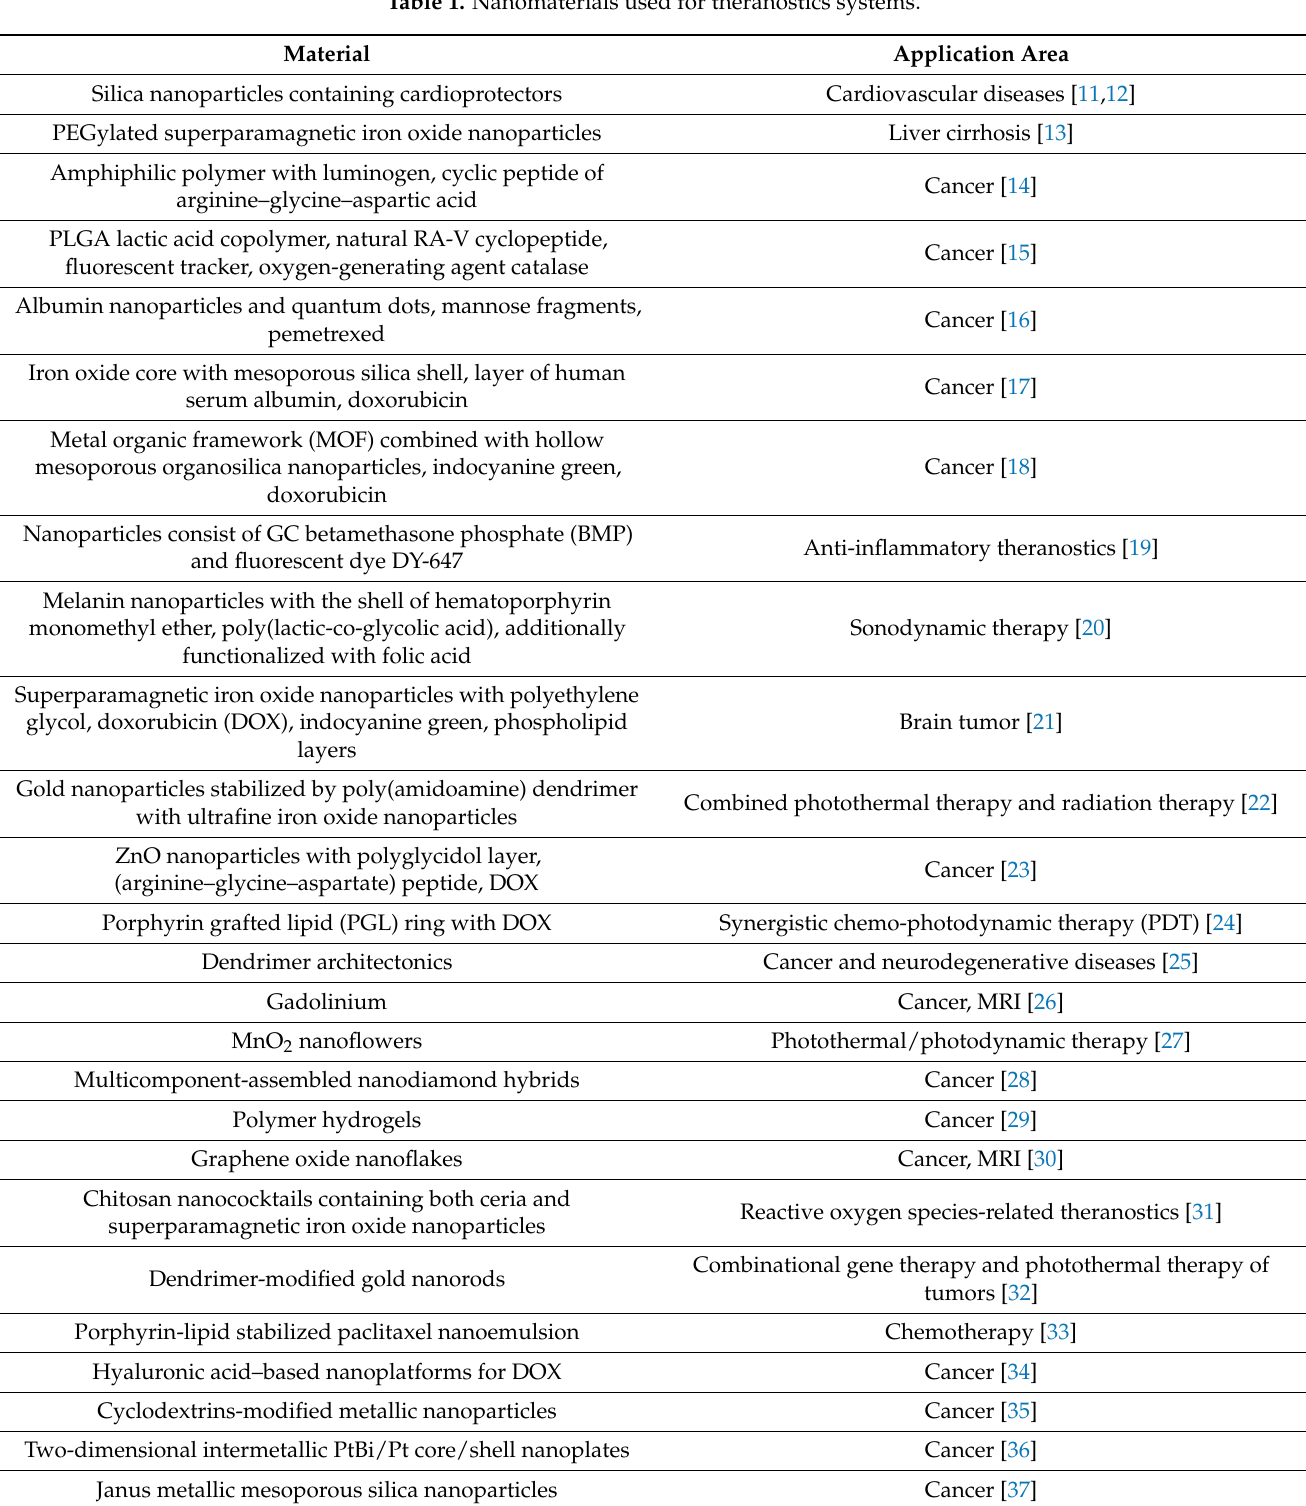
Table 1. Nanomaterials used for theranostics